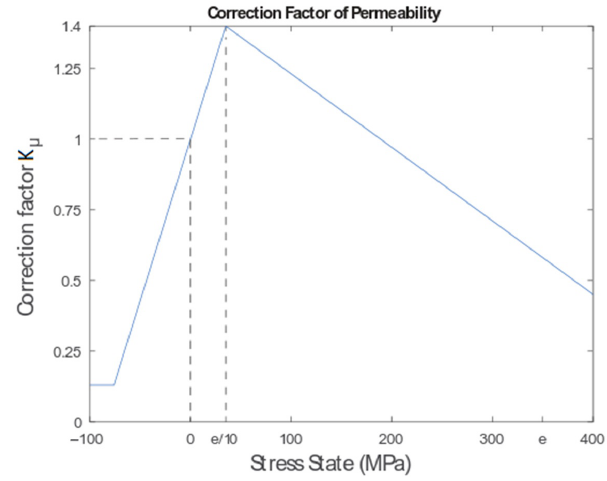
Figure 3. MEC model for a ring core with one weld seam where the flux perpendicular to the cross- section travels through parallel branches of healthy, degraded and welded material. The indices of the reluctances indicate different stress-dependent material properties corresponding to the regions described in Figure 2.